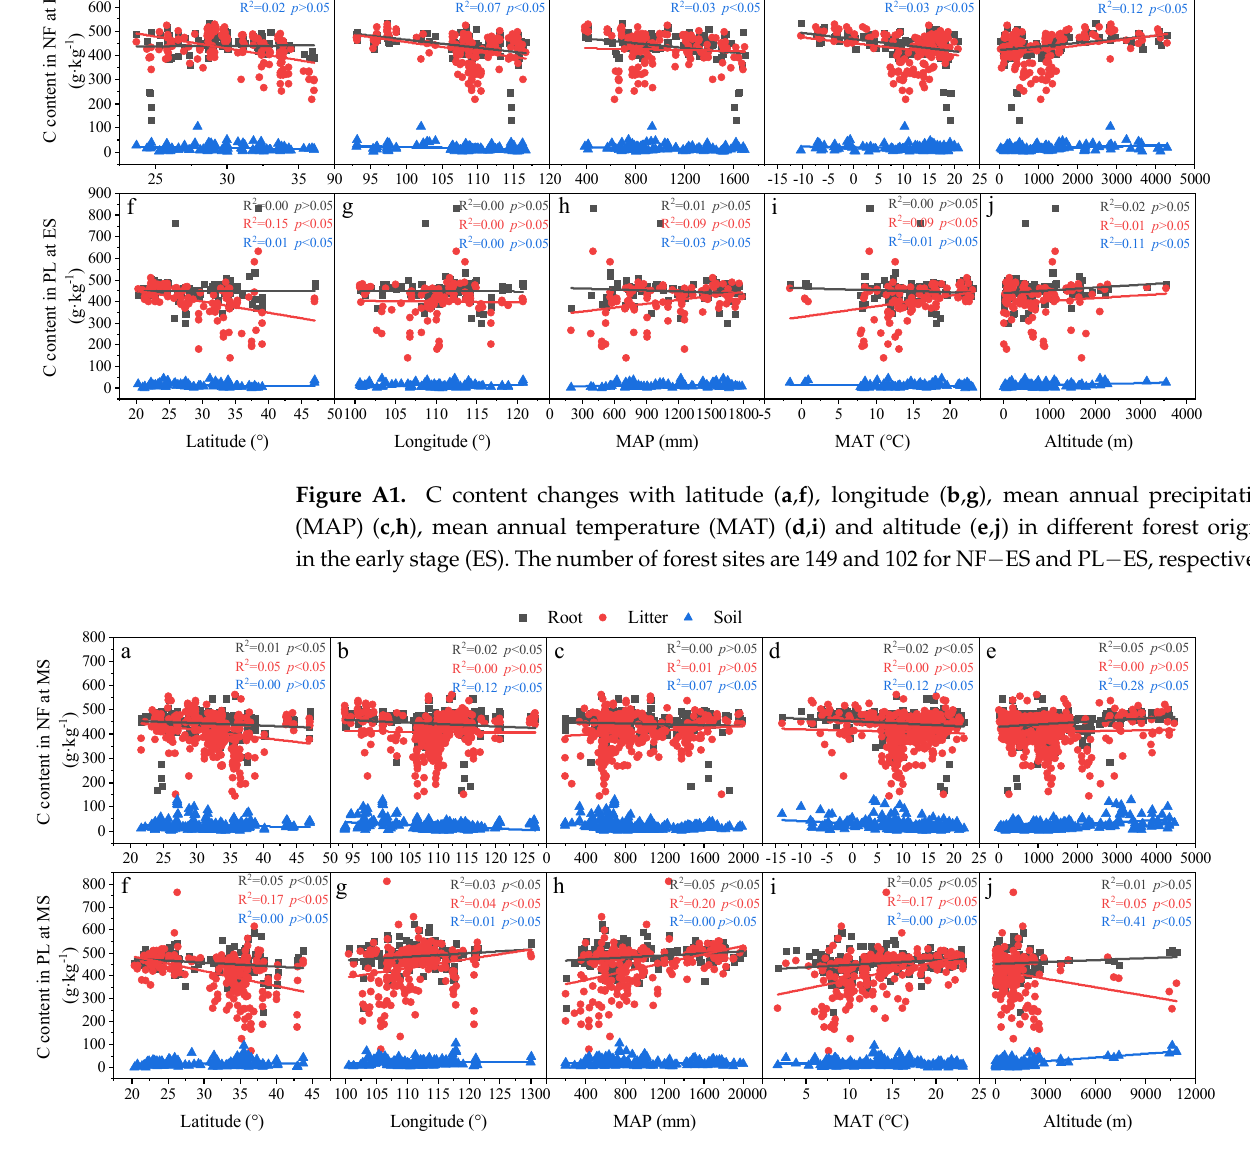
Figure A3. C content changes with latitude ( a , f ), longitude ( b , g ), mean annual precipitation (MAP) ( c , h ), mean annual temperature (MAT) ( d , i ) and altitude ( e , j ) in different forest origins in the late stage (LS). The number of forest sites are 114 and 144 for NF − LS and PL − LS, respectively.